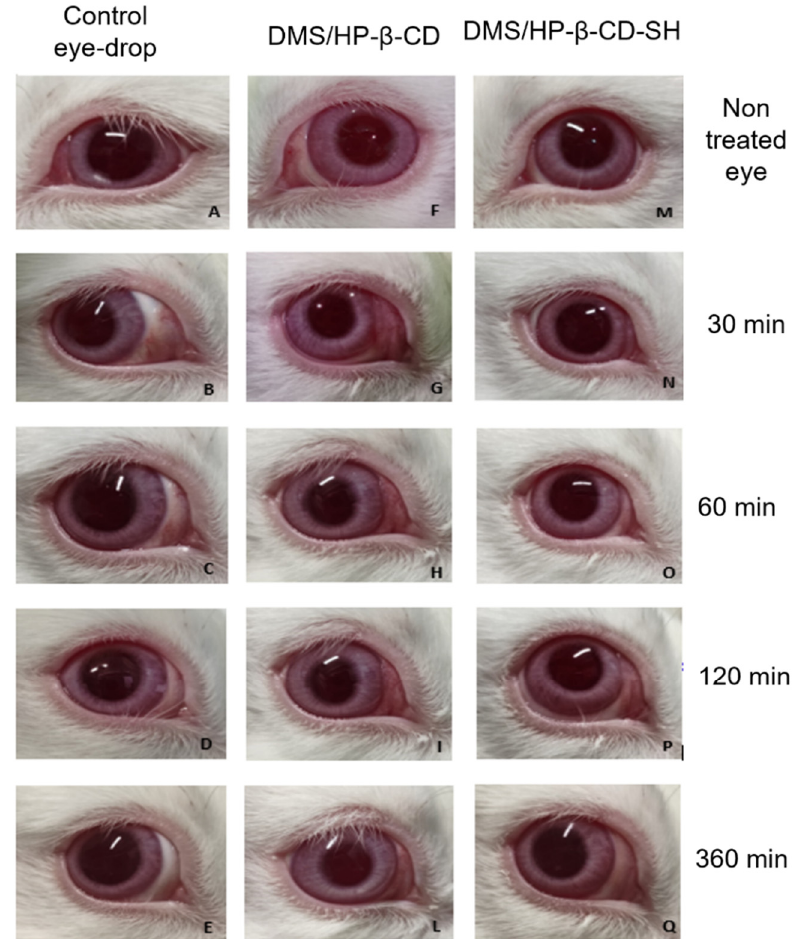
Figure 6. Modified Draize test representation. ( A ) Left untreated eye of rabbit used as reference; ( B – E ) the same rabbit right eye after instillation of one drop of eye drops containing 0.3% (m/V) DMS at times: 30 min, 1 h, 2 h and 6 h, respectively. ( F ) Left untreated eye of rabbit used as reference; ( G – L ) the same rabbit right eye after instillation of one drop of eye drops containing 0.3% (m/V) DMS and 12.5% HP- β -CD at the time: 30 min, 1 h, 2 h and 6 h, respectively. ( M ) Left untreated eye of rabbit used as reference; ( N – Q ) the same right rabbit eye after instillation of one drop of eye drops containing 0.3% (m/V) DMS and 12.5% HP- β -CD-SH at times: 30 min, 1 h, 2 h and 6 h, respectively.